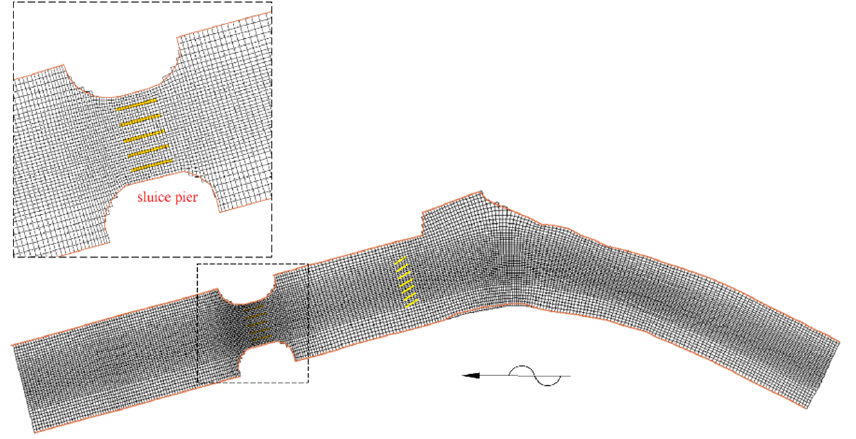
Figure 9. Meshed computational domain. The domain is covered by 15,350 cells, comprising 307 streamwise and 50 transverse.